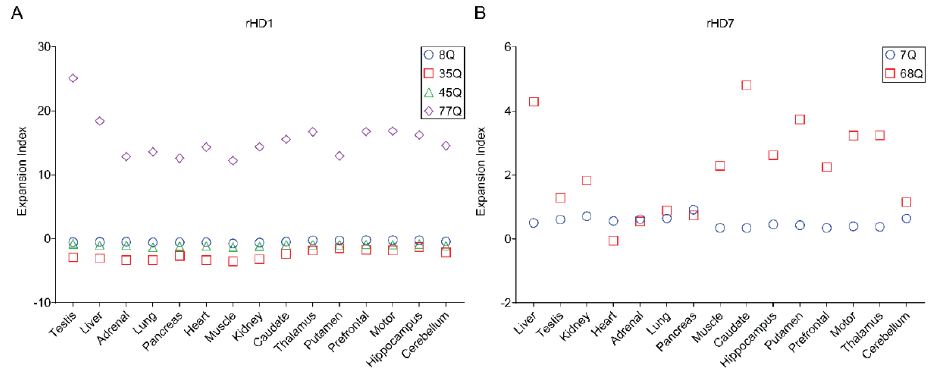
Figure 3. Expansion indexes of rHD1 and rHD7 peripheral and central nervous system samples are arranged in the same order as the curve-fit data. ( A ) All alleles, except 77Q, were stable. Like curve- fit data, testis and liver showed the highest instability compared to the rest of the peripheral tissue samples, although 77Q in all peripheral tissue samples showed a high expansion index. Among the central nervous system samples, 77Q alleles in all tissue samples showed similar instability. ( B ) All peripheral tissue samples, except the liver, showed similar instability in both 7Q and 68Q. In the central nervous system, the caudate showed the highest instability, followed by the putamen.